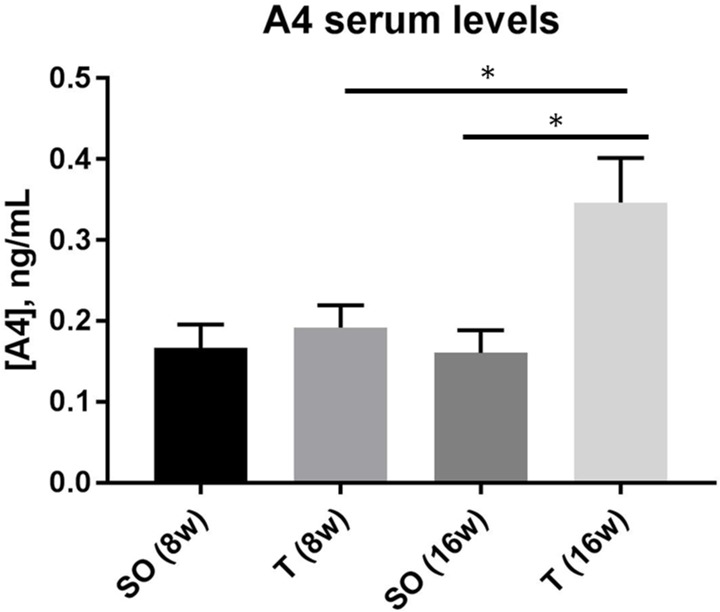
Serum A4 concentration is significantly higher in adult, but not early adolescent, prenatally androgenized rats.Sprague-Dawley rats were prenatally exposed to sesame oil or 5mg testosterone each day during gestation days 16–19. Serum samples, collected by tail vein blood draw at 8 and 16 weeks of age, were assayed by ELISA for A4. No significant difference in [A4] was detected at 8 weeks of age, but rats prenatally exposed to testosterone exhibited significantly greater [A4] as young adults compared to rats exposed to sesame oil, with a two-fold greater level in the PNA rats (16 weeks of age, n = 8 for each group, 2-way ANOVA with Tukey’s, * p < 0.05). Values are means ± SEM. SO, sesame oil prenatal exposure; T, testosterone prenatal exposure.